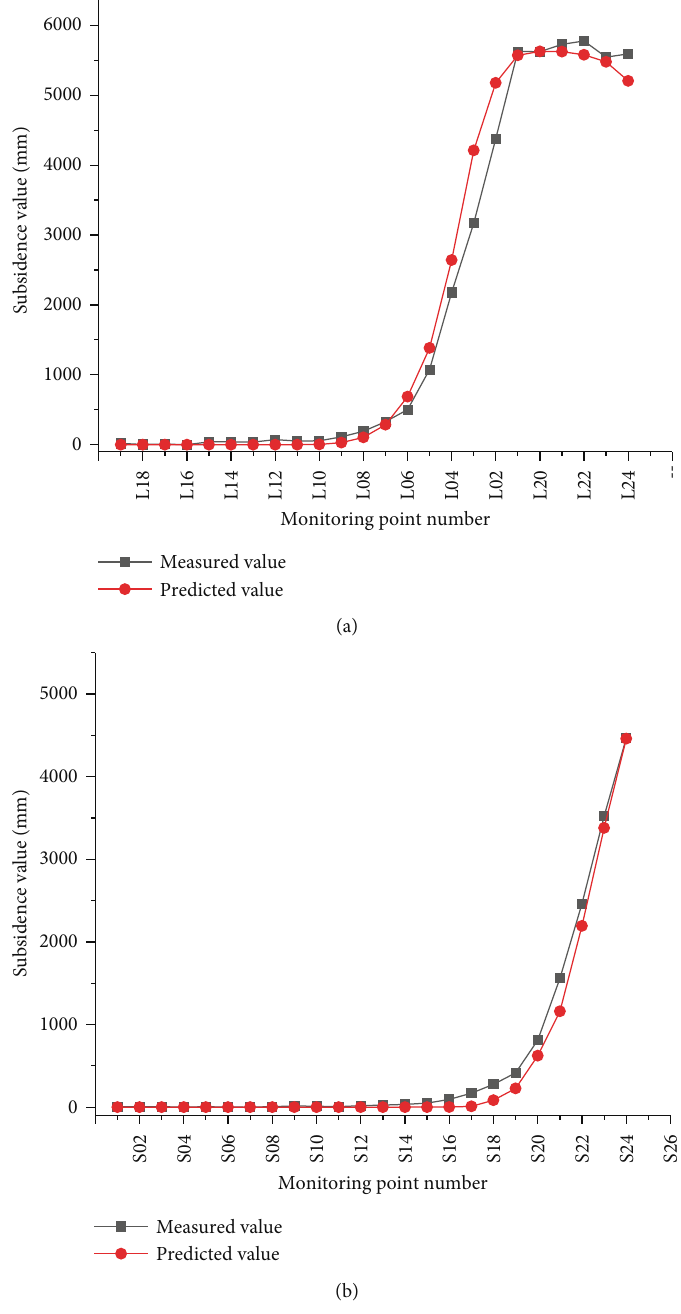
Figure 9: Comparison of predicted and measured